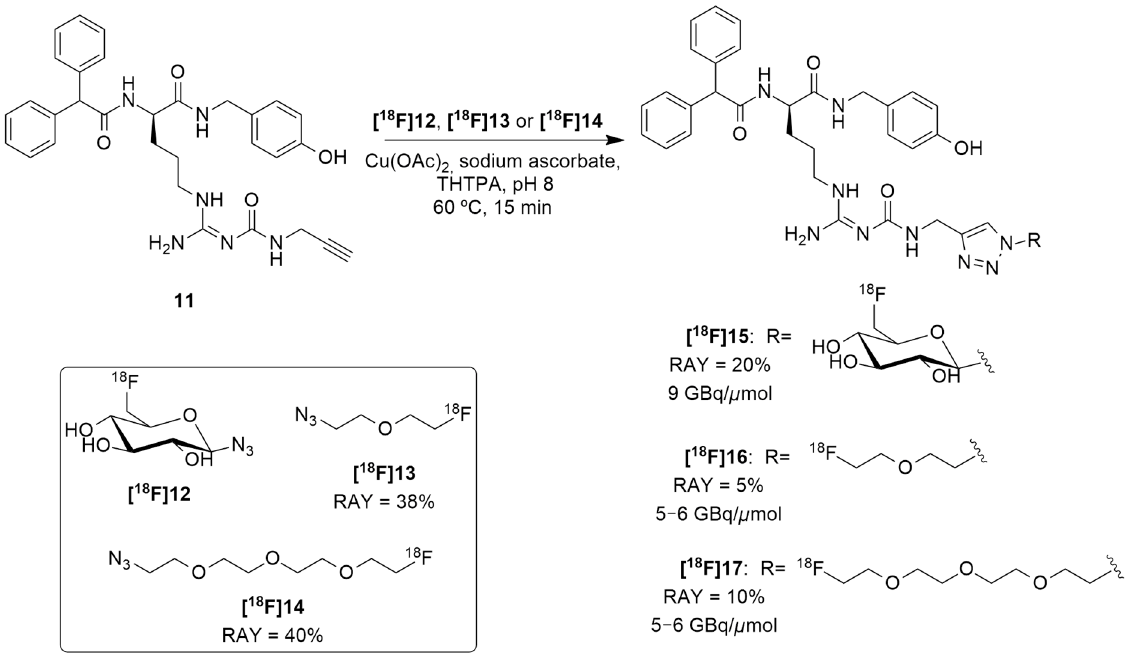
Figure 6. Radiosynthesis of [ 18 F]15 , [ 18 F]16 and [ 18 F]17